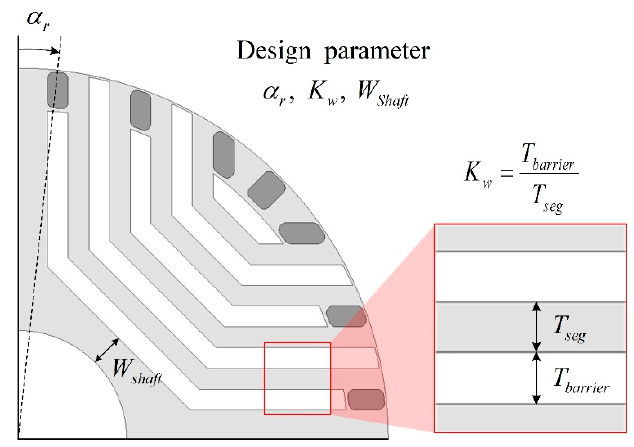
Figure 7. Design parameters for the optimal design using the response surface method (RSM). Table 5. Range of design parameters.